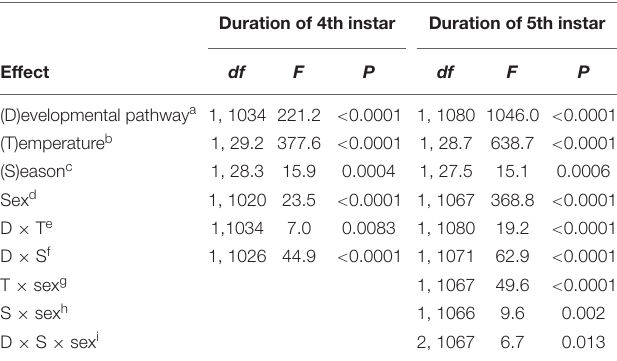
TABLE 1 | Duration of the 4th and 5th instar of Araschnia levana larvae as explained by developmental pathway (direct vs. diapause development), temperature (17 vs. 20 ◦ C), season (June vs. August), and sex; linear mixed models (SAS, Proc MIXED, type 3 sums of squares) with brood (progeny of one female) as a random effect.